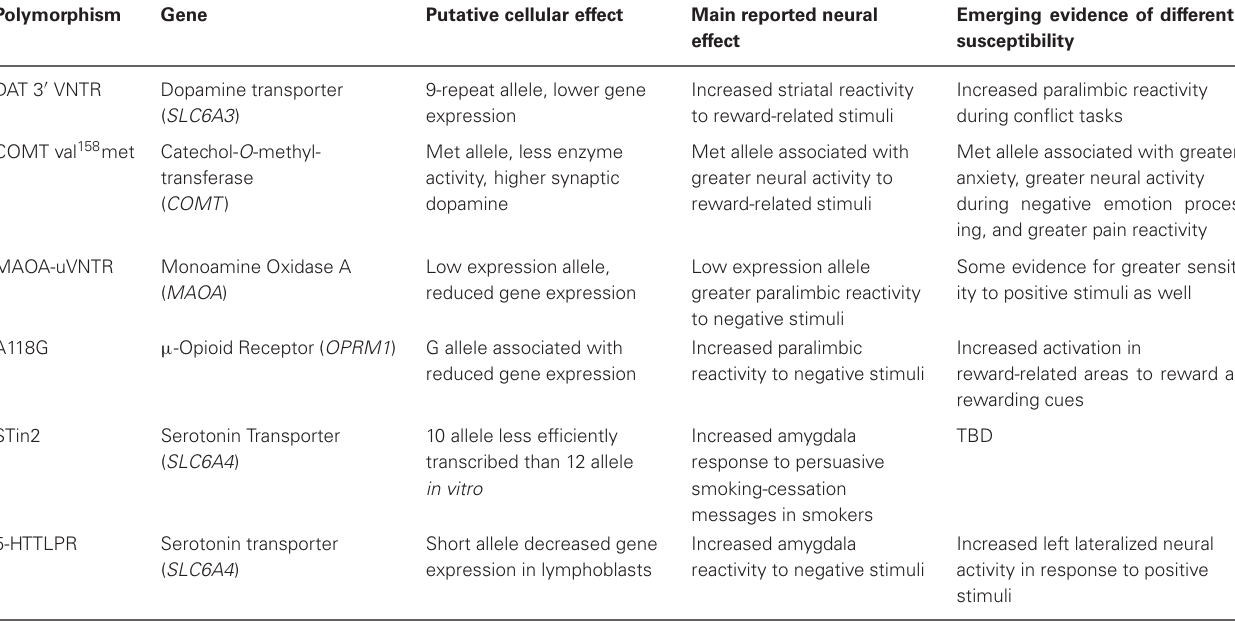
Table 1 | Summary of genetic variants implicated in the modulation of neural and behavioral sensitivity to social influences.